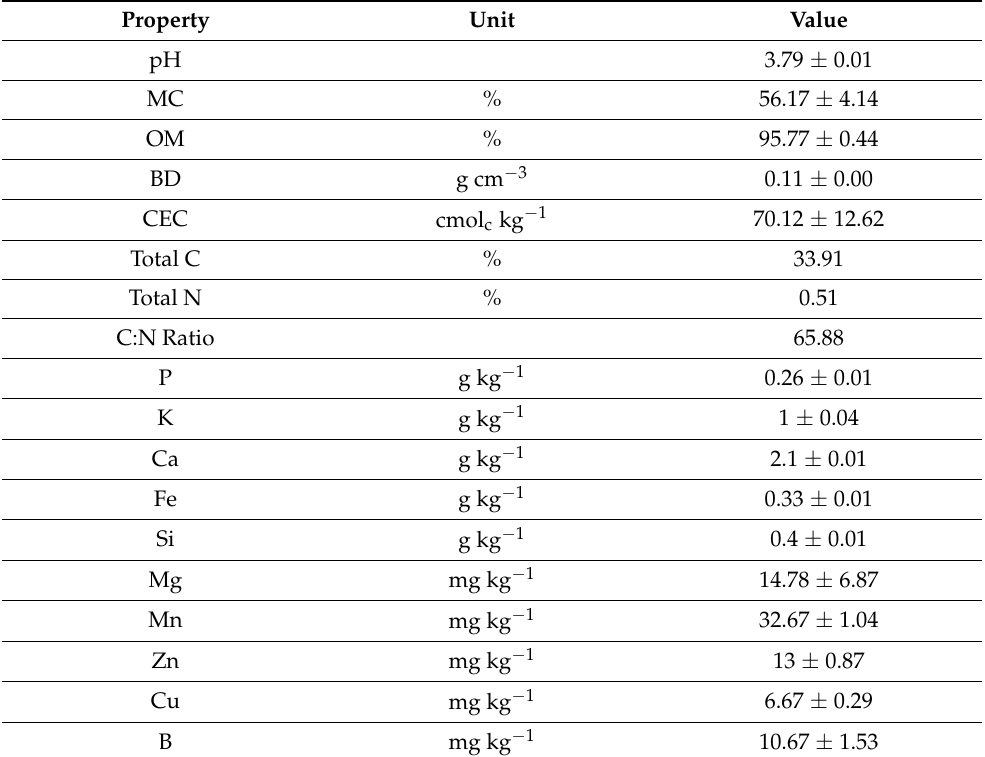
Table 2. Basic physiochemical properties of bagasse in the experiment site ( n = 6) (mean and standard deviation) (reported as dry